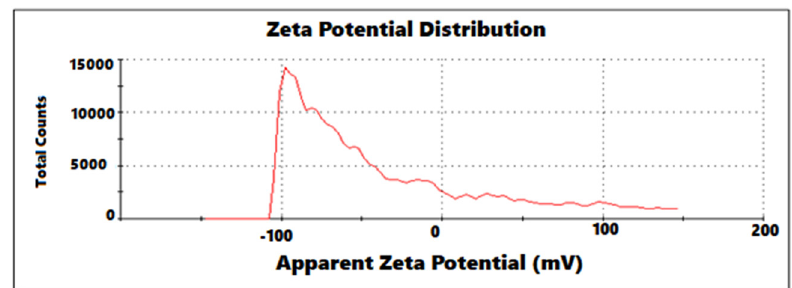
Figure 3: Zeta potential distribution of green - synthesized A. digitata AgNPs.